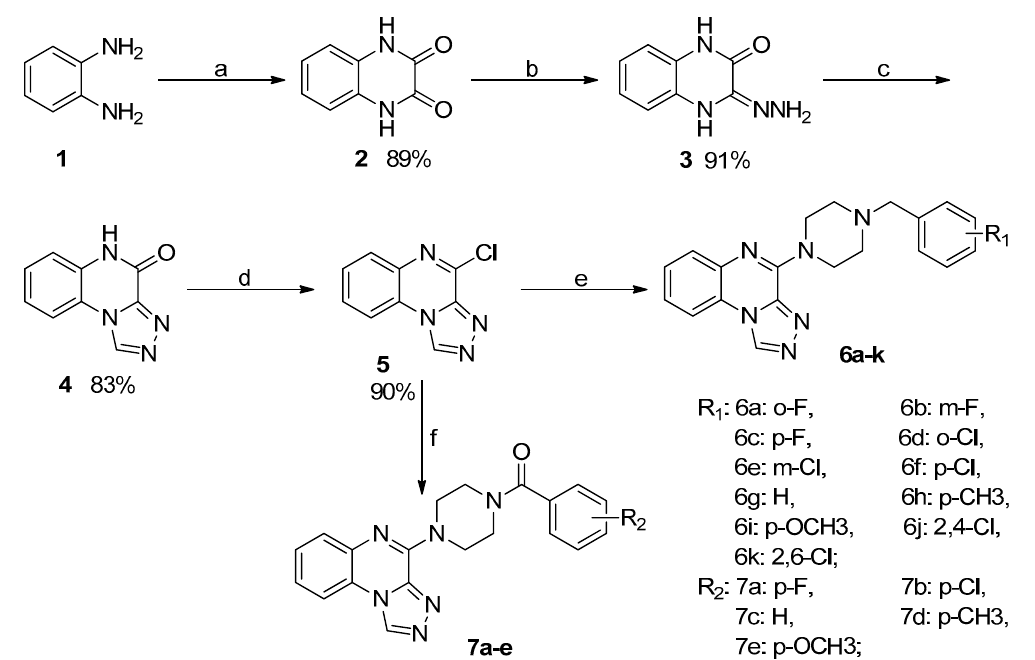
Scheme 1. Synthetic scheme for the synthesis of compound 6a – k and 7a – e . Reagents and conditions: